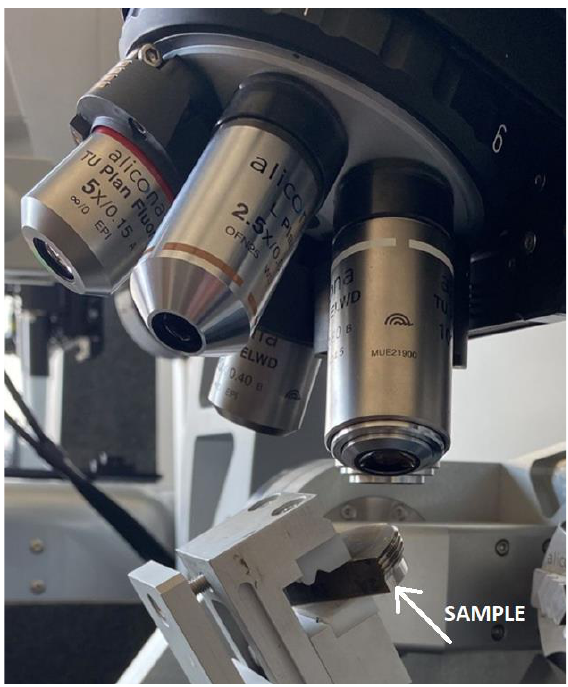
Figure 2. View of the measuring station with the InfiniteFocus G5 instrument.